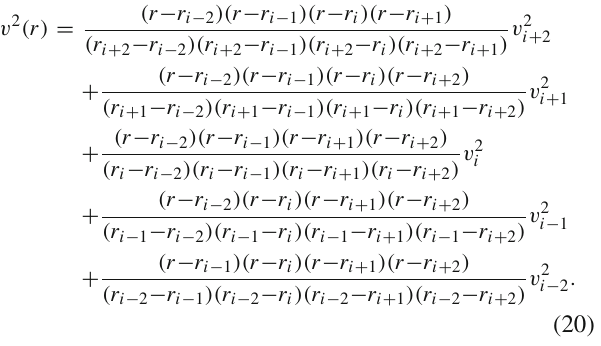
p = αρ + β . As an illustration of the order of magnitude for the parameter α , its value for the Milky Way rotation curve data, assuming the flat part for the studied area with r 0 > 28 kpc , is α = ( 2 . 3 ± 0 . 1 ) · 10 10 m 2 / s 2 . As